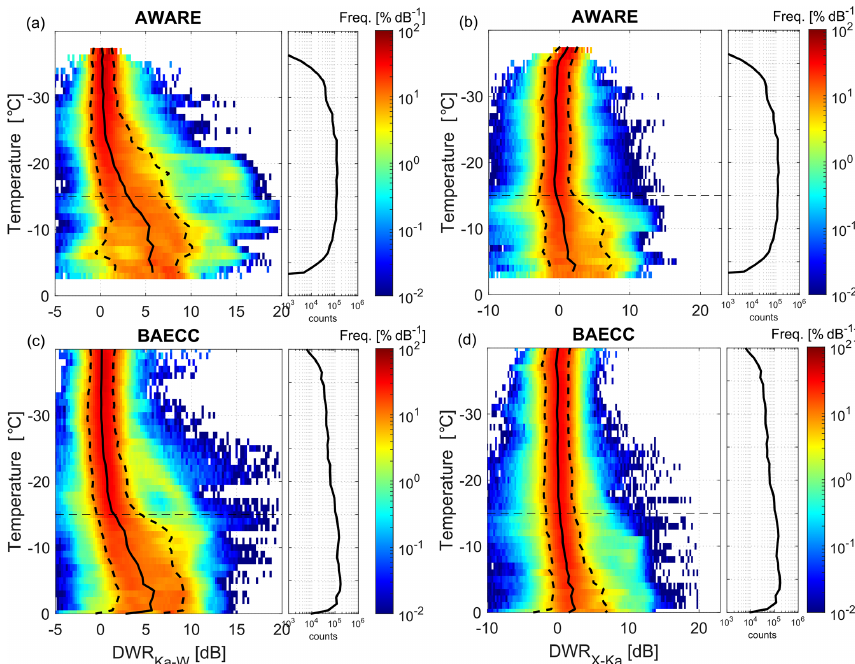
Figure 1. Density plots of DWR Ka , W (a, c) and DWR X , Ka (b, d) as a function of temperature for AWARE (a, b) and BAECC (c, d) datasets. The dashed lines indicate the 10th and 90th percentiles. The subplots on the right of each panel indicate the number of samples per temperature